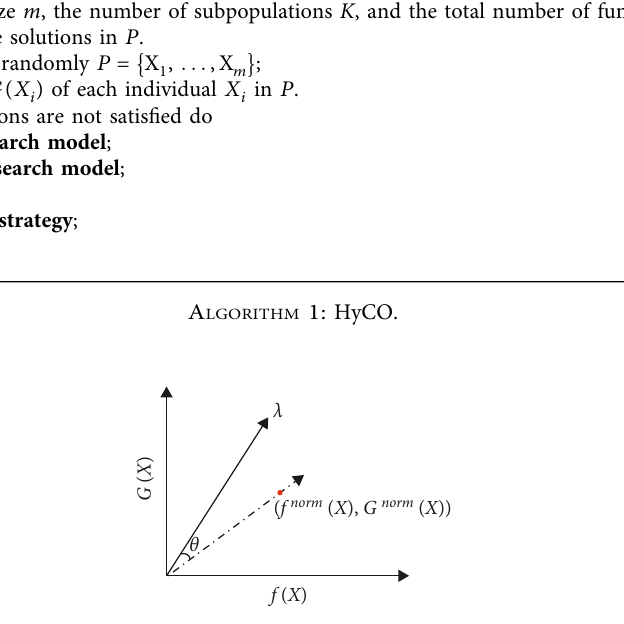
Figure 1: Illustration of the angle between the direction vector and the normalized objective vector.